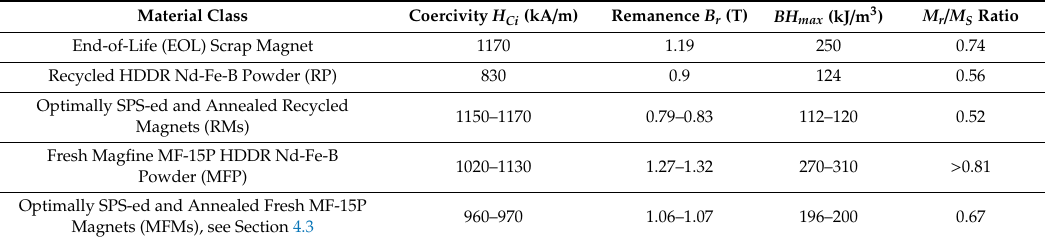
Table 1. Magnetic properties of HDDR Nd-Fe-B magnets prior to Pr-Cu and Dy-Cu